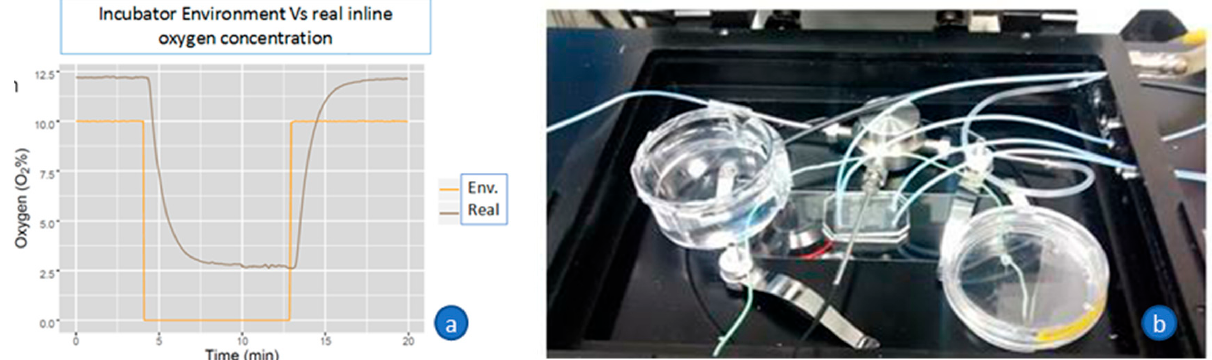
Figure A2. Oxygen monitoring. ( a ) System response; ( b ) Measuring setup.